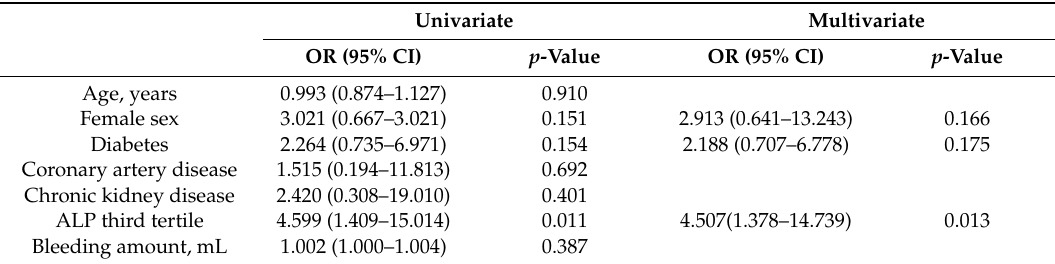
Table 4. Logistic regression analysis of variables predicting incidence of 30-day major adverse cardiac and cerebrovascular events.